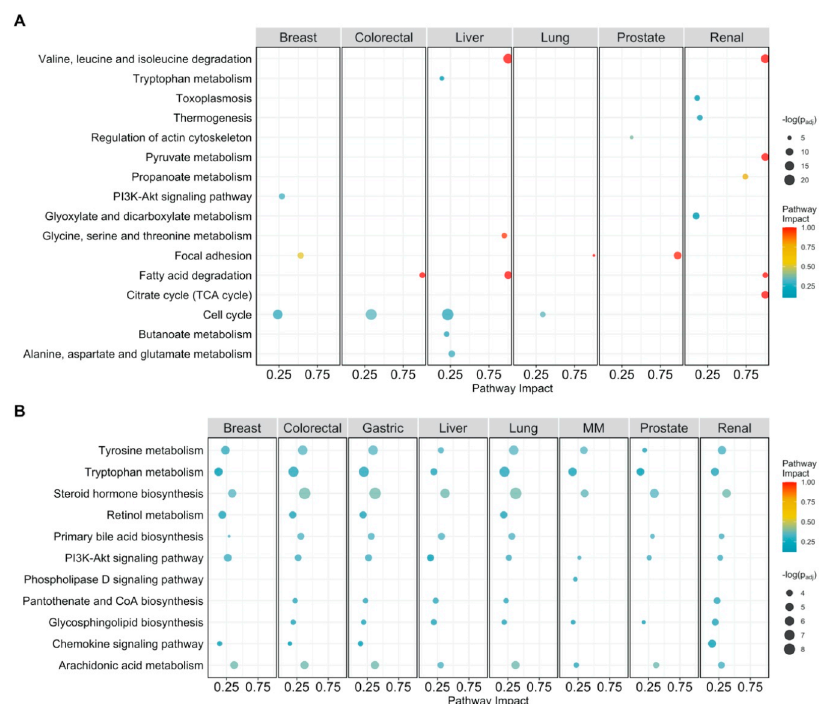
Figure 3. Pathway analysis plot showing the impact on cellular pathways that are significantly enriched ( p adj < 0.05 ) and have a pathway impact score > 0.1 per cancer type. Datapoints are colored according to their impact score. Multiple myeloma is abbreviated as MM. ( A ) Pathway impact according to differentially expressed genes ( p adj < 0.05 ); ( B ) pathway impact according to differentially connected genes ( p adj < 0.05 ). p adj indicates Benjamini–Hochberg corrected p